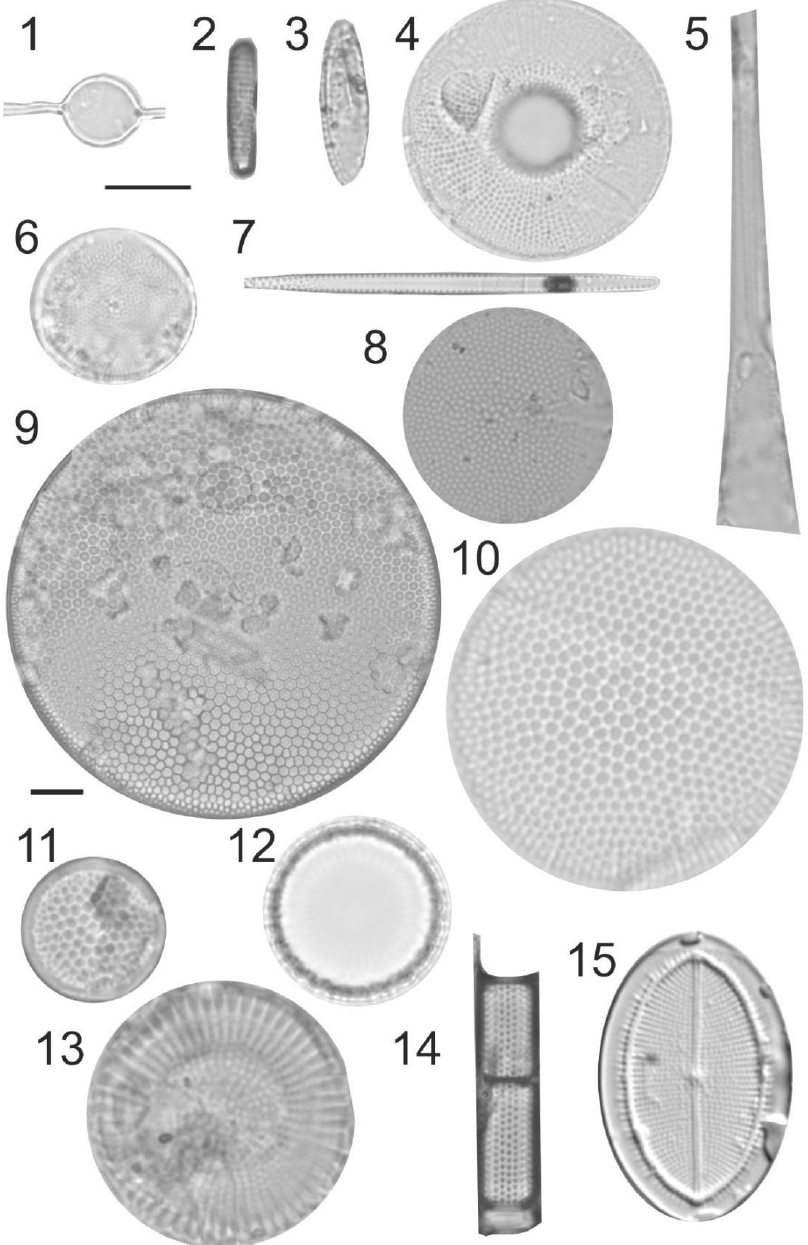
Figure 5. Photomicrographs (bright-field images) of diatoms recovered from 2017 to 2018 sediment trap moorings in the Barents Sea, taken with an Axiocam 305 color microscope camera mounted on a Zeiss Axio Imager.A2 light microscope with EC “Plan-Neofluar” 100x/1.30 Oil objectiv. ( 1 ). Attheya septentrionalis , August 2017. ( 2 ). Fragilariopsis cylindrus , September 2017. ( 3 ). Fragilariopsis oceanica , September 2017. ( 4 ). Bacterosira bathyomphala , September 2017. ( 5 ). Rhizosolenia hebetata f. hebetata , August 2017. ( 6 ). Thalassiosira nordenskioeldii , August 2017. ( 7 ). Thalassionema nitzschioides , October 2017. ( 8 ). Thalassiosira eccentrica , November 2017. ( 9 ). Coscinodiscus perforatus , January 2018. ( 10 ). Coscinodiscus radiatus , August 2017. ( 11 ). Shionodiscus oestrupii , March 2018. ( 12 ). Paralia sulcata , April 2018. ( 13 ). Stephanodiscus rotula , March 2018. ( 14 ). Aulacoseira granulata , May, 2018. ( 15 ). Cocconeis placentula , March 2018. Scale bar 10 µ